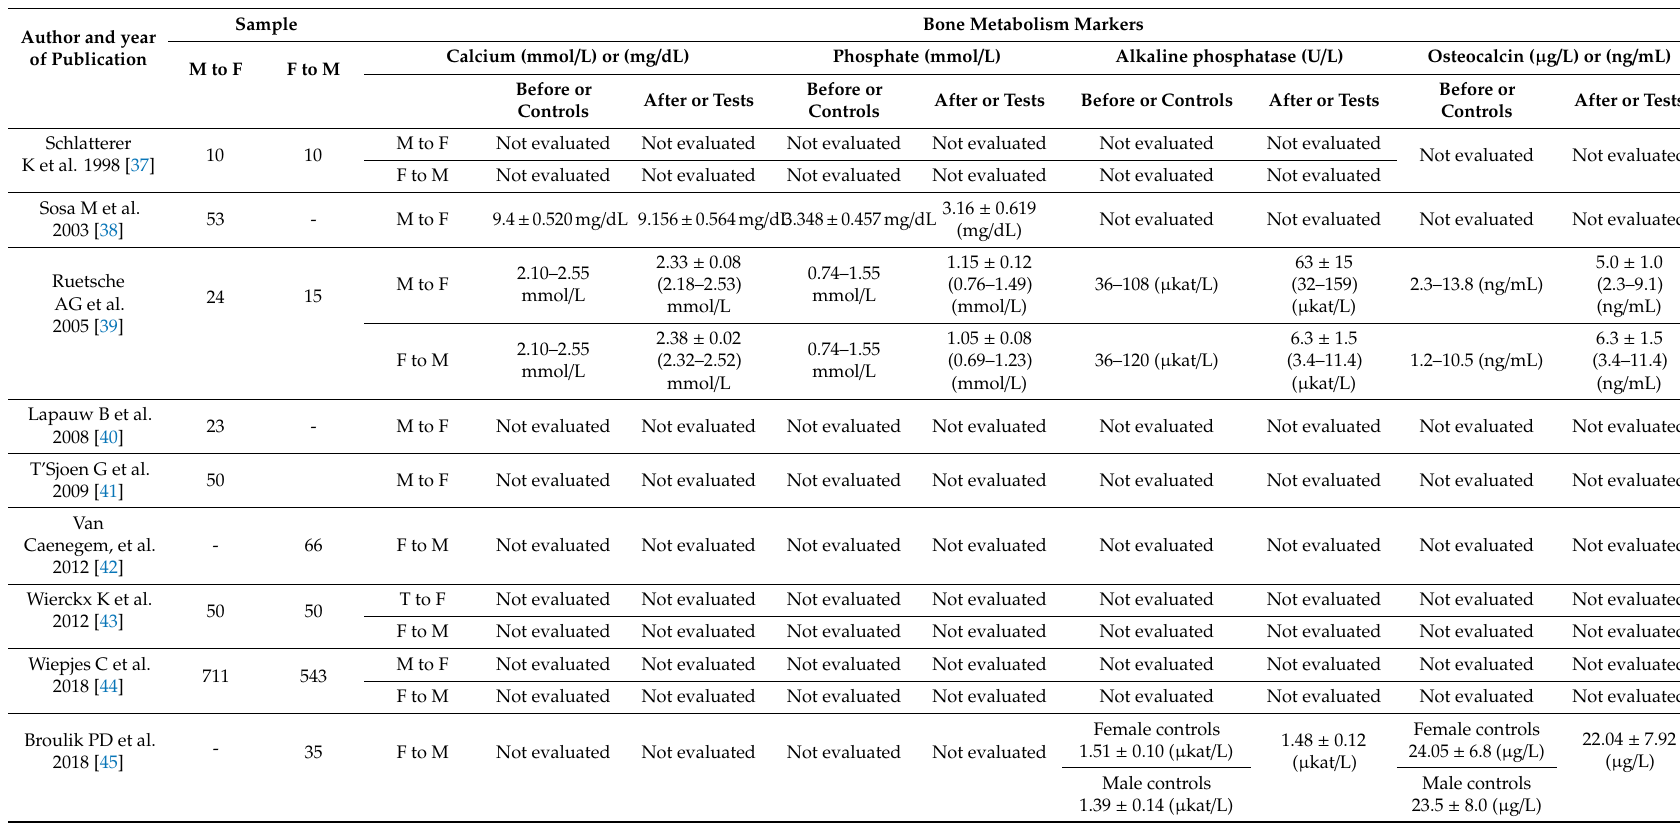
Table 2. Bone metabolism markers were reported in three of the included studies. No di ff erences were observed before and after long-term pharmacotherapy for transmen or